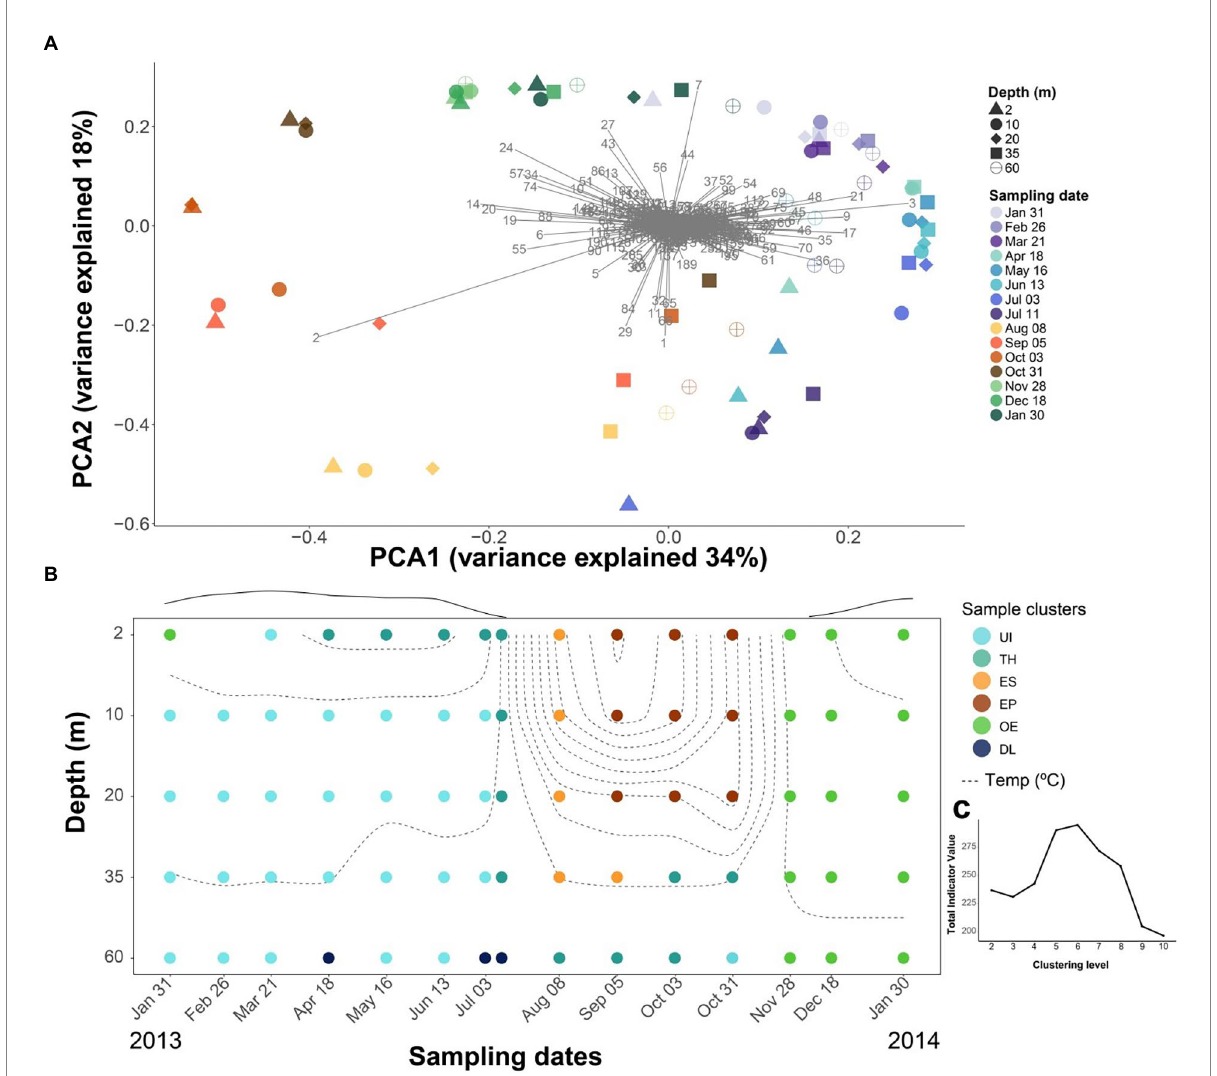
FIGURE 3 Seasonal difference in bacterioplankton community composition. (A) PCA analyses using Hellinger distance of the bacterioplankton OTUs. Numbers refer to OTUs listed in Supplementary Table S4. There is a seasonal trajectory for the upper layers (2, 10, 20-m depth), whereas variation is lower in the deeper layers (35, 60-m depth). (B) Temporal depth distribution of the bacterioplankton groups was obtained using k-means clustering with Hellinger distance. Dashed lines denote isotherms. Circles indicate sampling points, and the color corresponds to each of the six clusters: UI (under-ice), TH (thaw and hypolimnion), ES (early stratification), EP (epilimnion), OE (overturn and early under-ice), and DL (deep layers). The line above the graph indicates the snow and ice-cover thickness in arbitrary units. (C) The best number of k-means groups was assessed by maximizing the total indicative value (IndVal) of the significant OTUs at each